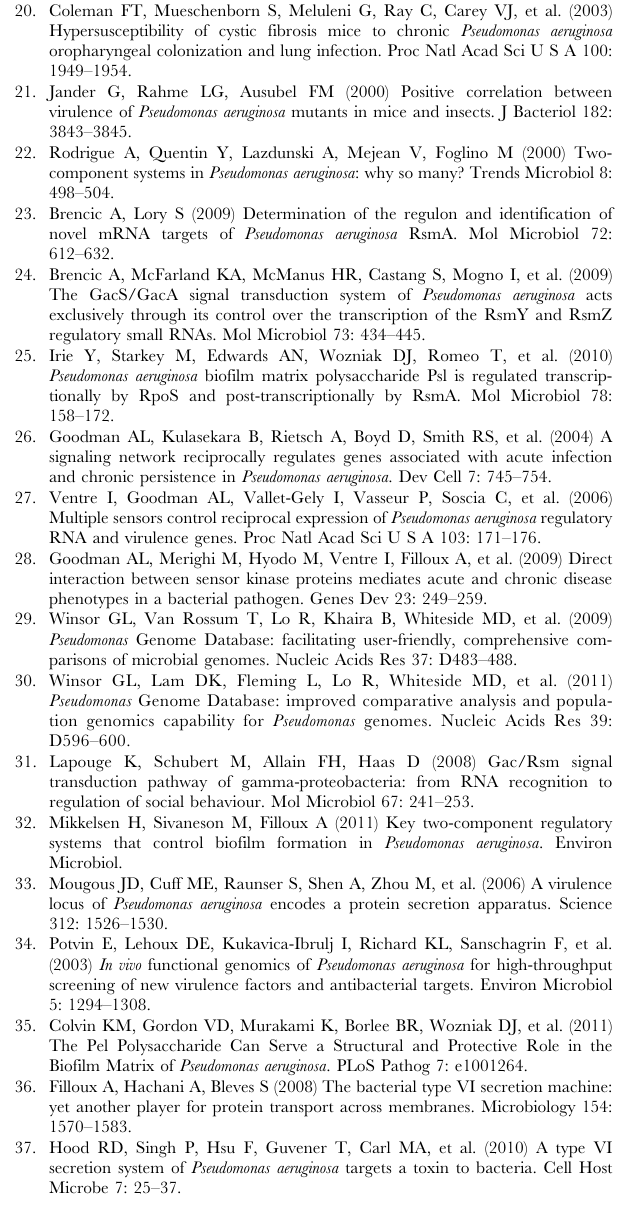
Figure S2 PCR of a section of the ladS gene in PAO1, PA14 and four environmental isolates (Lee et al. 2006) as indicated using primers ladSF and ladSR (Table S1). Figure S3 C. elegans slow killing assay. L4 larvae were transferred onto lawns of PA14 or ladS R as previously described (Powell &